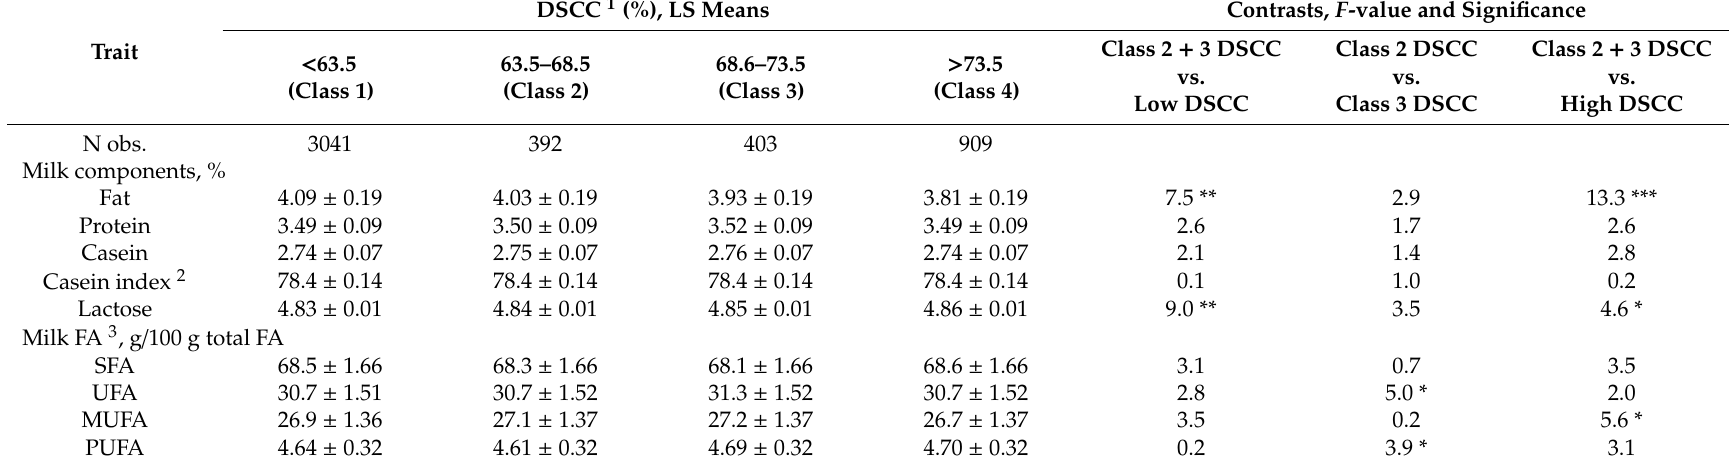
Table 4. L SMeans and Standard Errors of DSCC ranges according to M-5 DSCC model for milk components and groups of fatty acids (FA), and their orthogonal contrasts ( F -value and